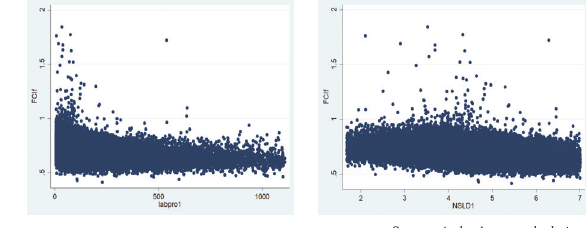
Fig. 1. Relationship between FCIf and VA and Total Assets of firm ( Source: Author’s own calculations ) Fig.1 presents the scatter plot of financial constraint index FCIf and Value Added (VA) and firm scale of the total assets, Fig.1 shows that firms with low FCIf index, the scale of Value Added and assets is higher. There is a clear effect of financial constraints on the firm performance.